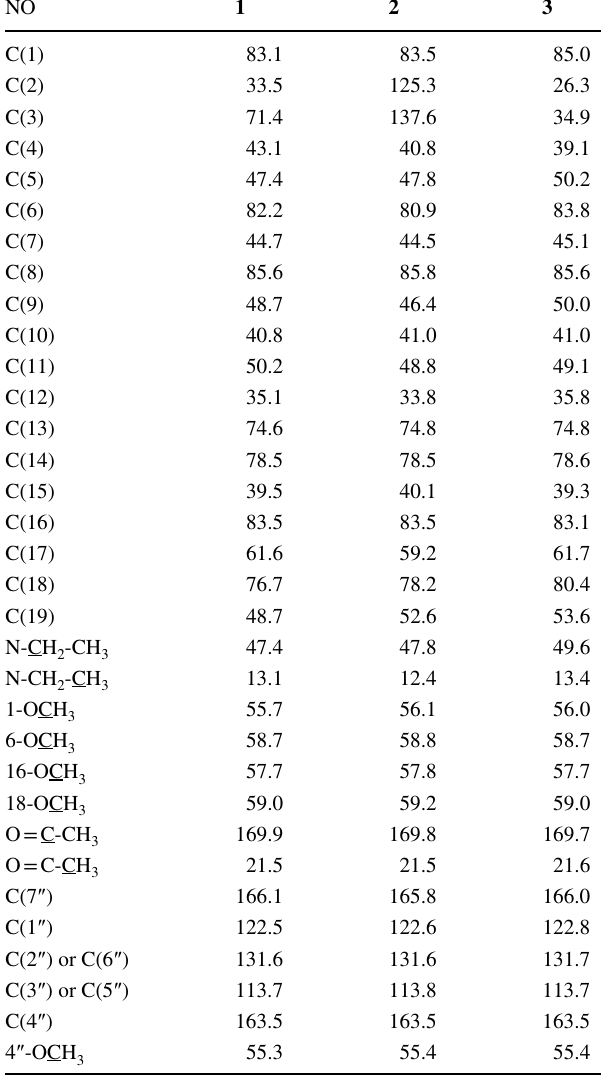
Table 1 13 C NMR Data of compounds 1, 2, 3 in CDCl